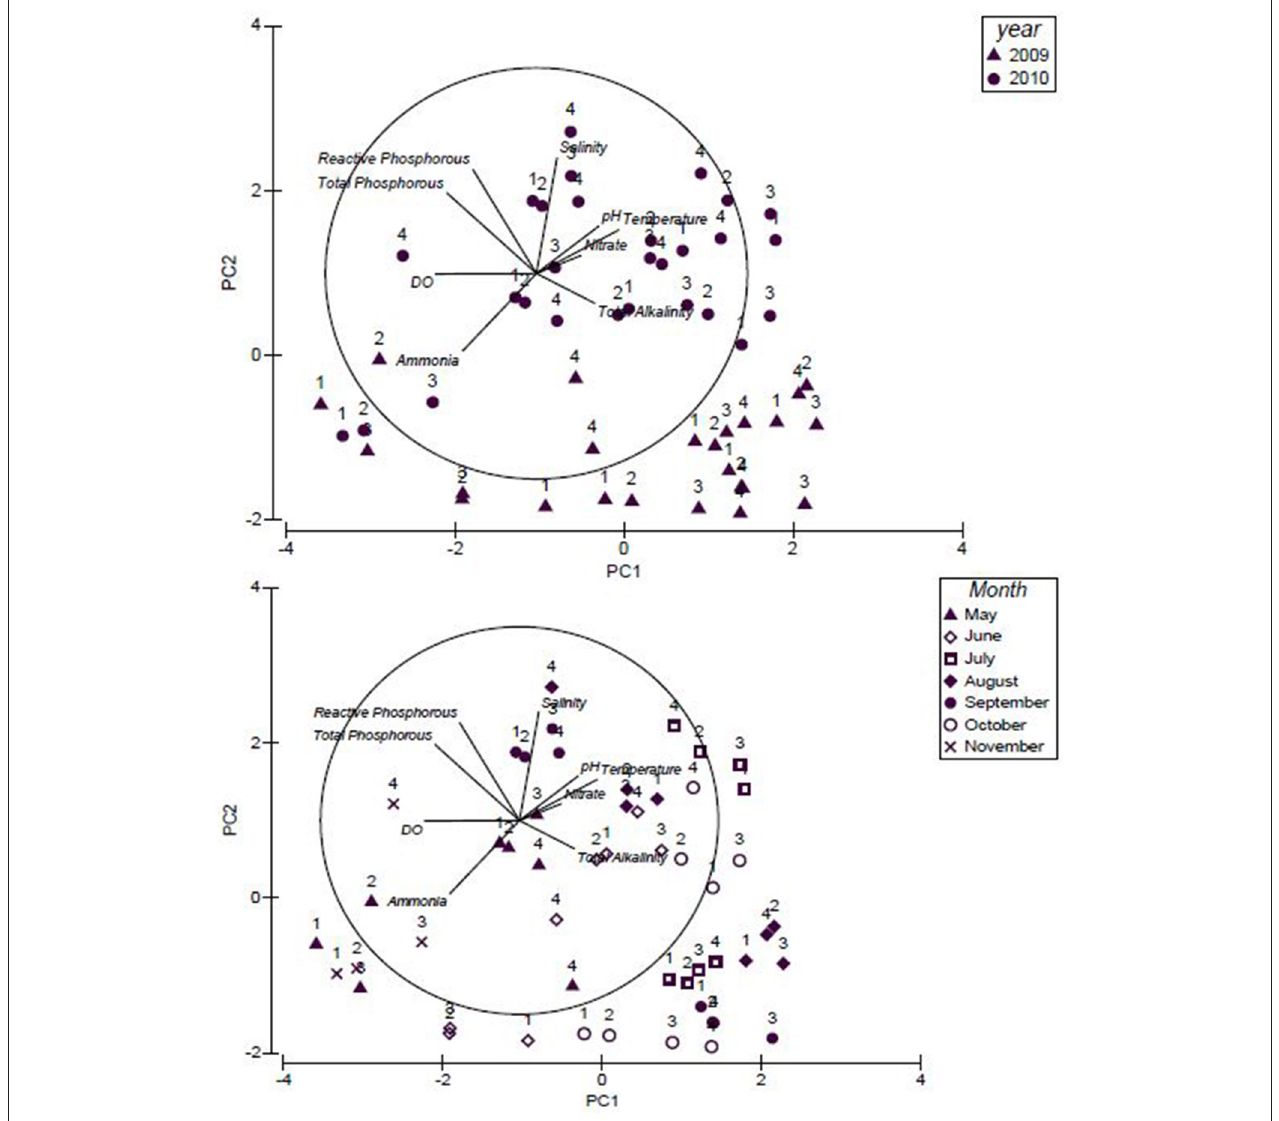
FIGURE 4 | Principal Component Analysis (PCA) plot for the water quality of the upstream and downstream sites for the study years, 2009 and